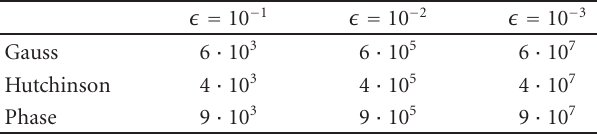
Table 2: This table showsthe theoretical lower bounds (see Table 1) on the batch size K for δ = 10 − 1 for the matrix shown in Figure